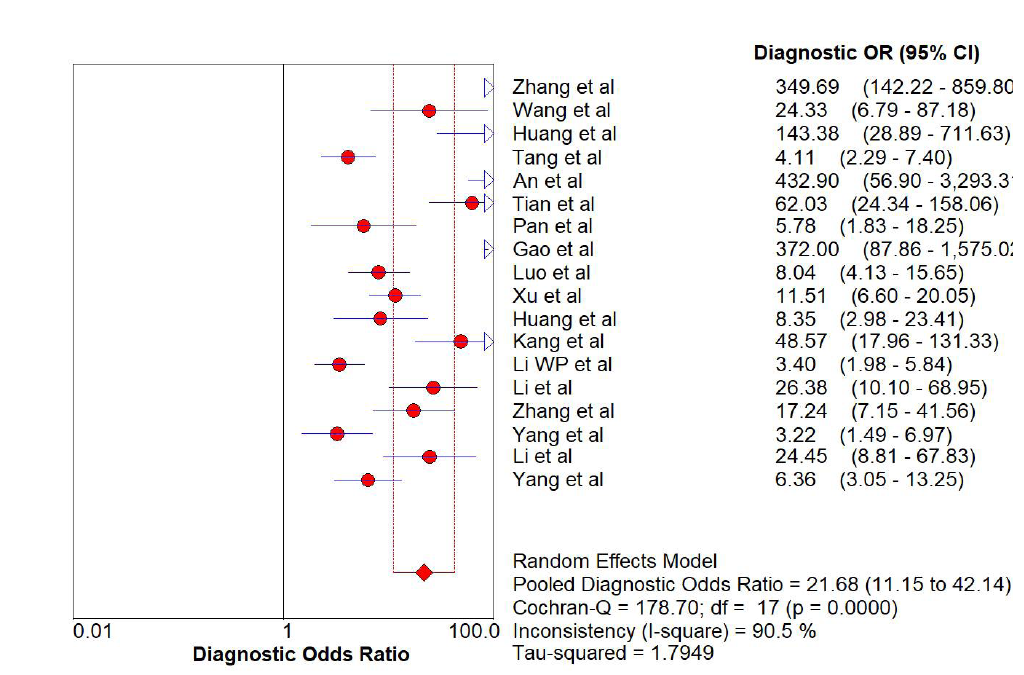
Figure 5: The forest plot of DOR for serum Hcy in diagnosis of